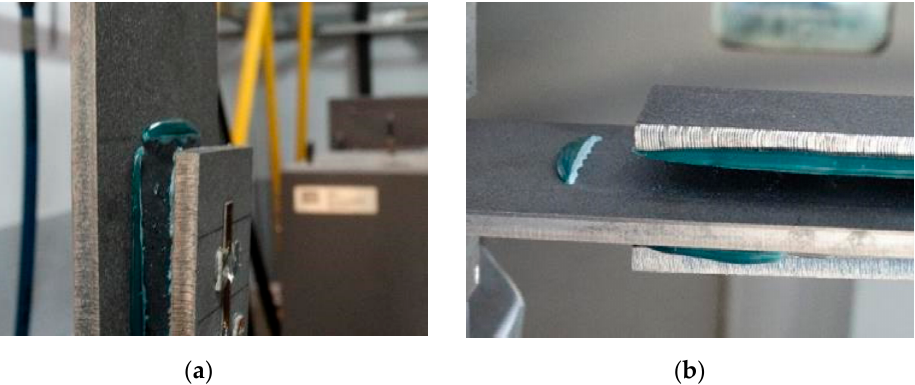
Figure 10. Specimens after failure: ( a ) model with an effective anchorage length of 200 mm; ( b ) model with an effective anchorage length of 400 mm.